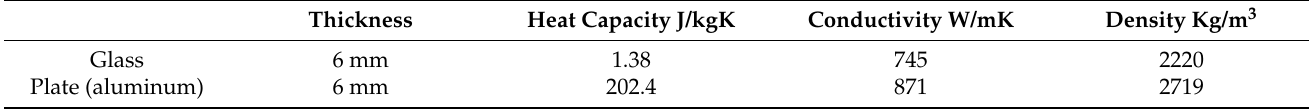
Table 1. Physical properties of the solar chimney module